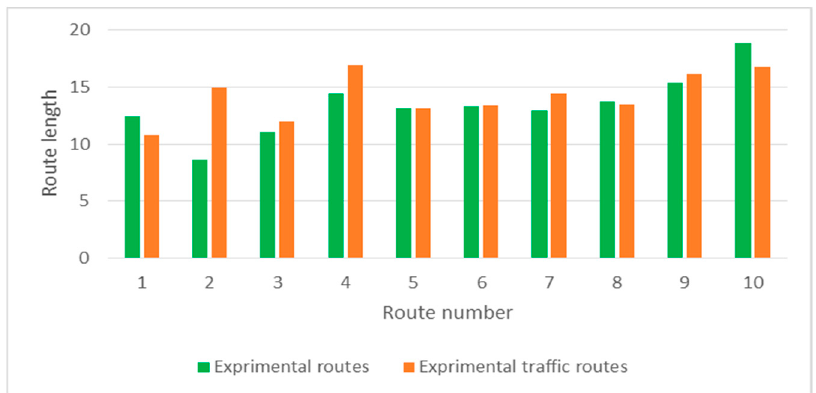
Figure 8. Comparison of travel length for two cases of the proposed method.